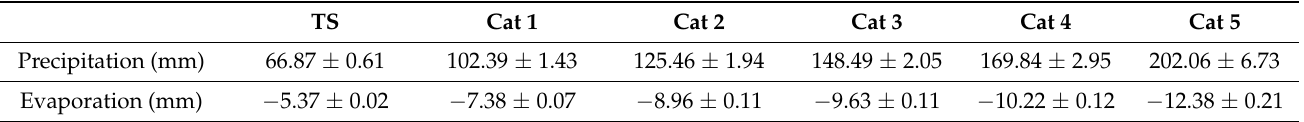
Table 2. Composite mean and standard error of daily accumulated precipitation and evaporation on day 0 for different TC intensity categories during March 2015 to December 2019. The composite variables are averaged over a 2 ◦ × 2 ◦ TC-centered